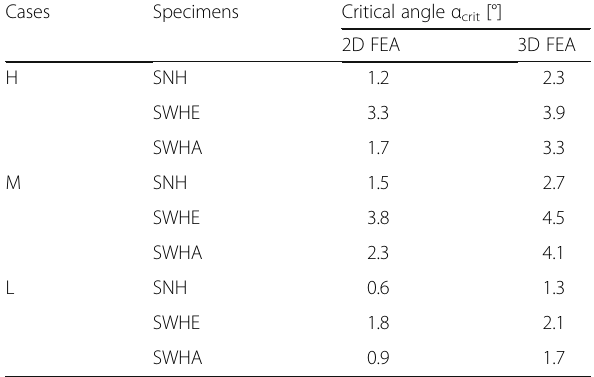
Table 13 Calculated critical angles based on the strain approach